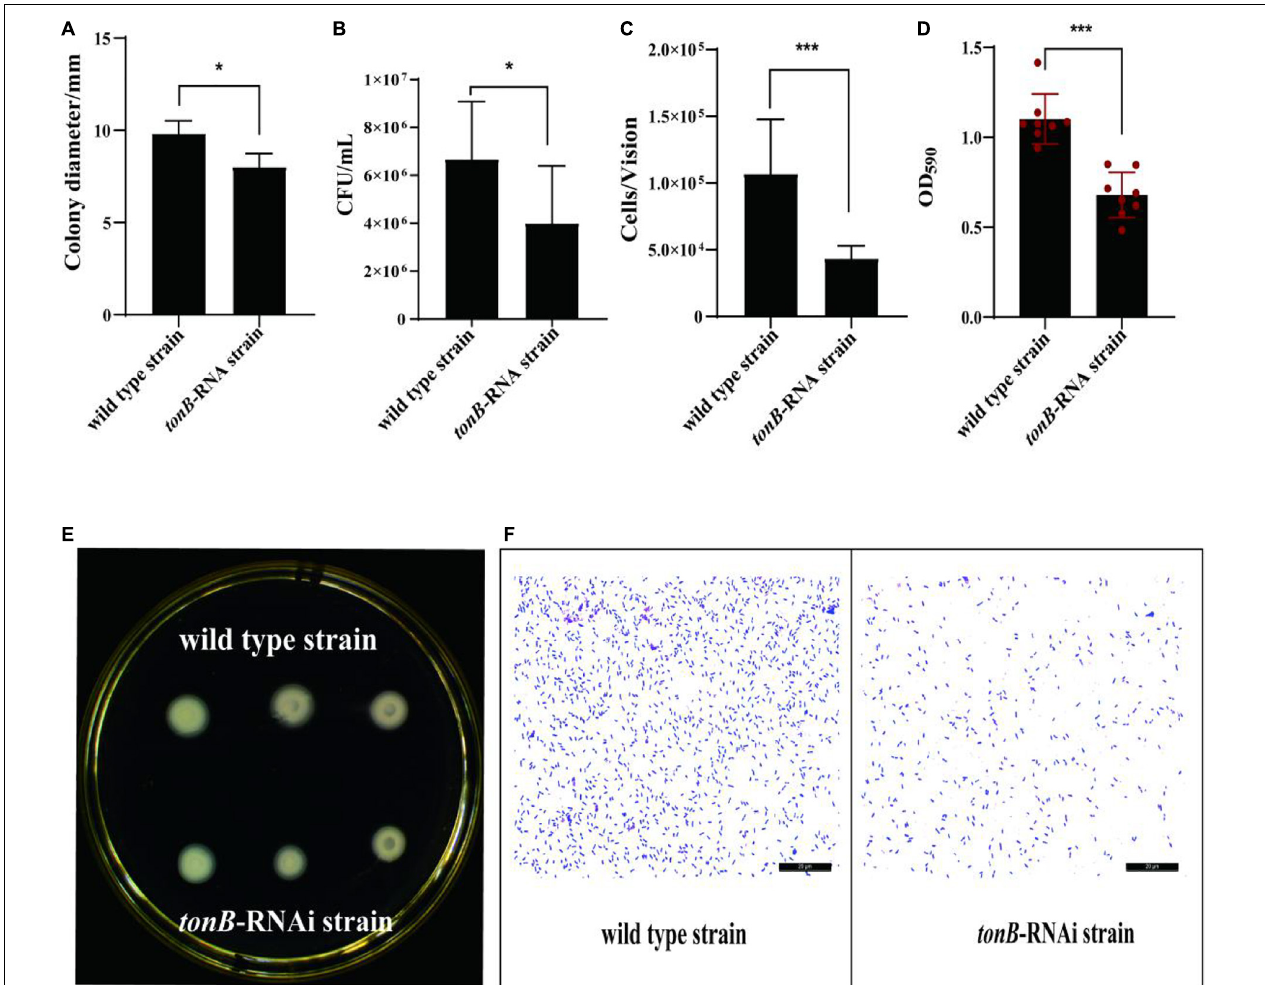
FIGURE 2 | The characteristics of two strains of Pseudomonas plecoglossicida . (A) Colony diameters of wild-type strain and tonB -RNAi strain. (B) Chemotaxis capacity of wild-type strain and tonB -RNAi strain. (C) Adhesion ability of wild-type strain and tonB -RNAi strain. (D) Biofilm formation ability of wild-type strain and tonB -RNAi strain. (E) Colonies of wild-type strain and tonB -RNAi strain on a plate. (F) Adhering bacteria under the microscope. Data are presented as mean ± SD. * p < 0.05, ** p < 0.01, *** p < 0.001.